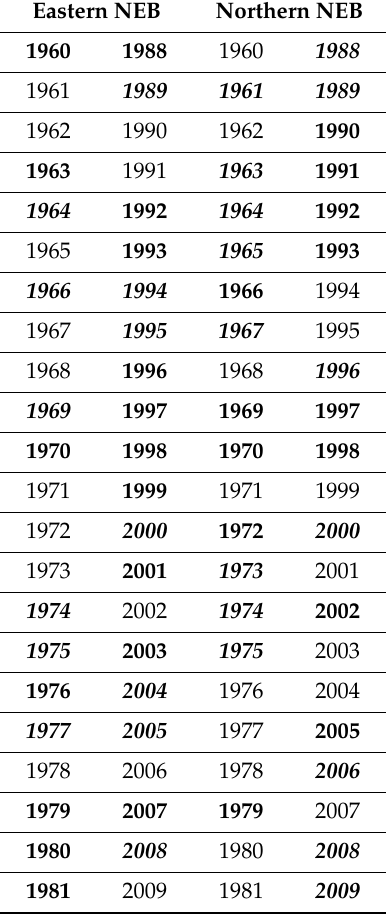
Table 2. Years corresponding to the selected positive (WET; bold italic) and negative (DRY;